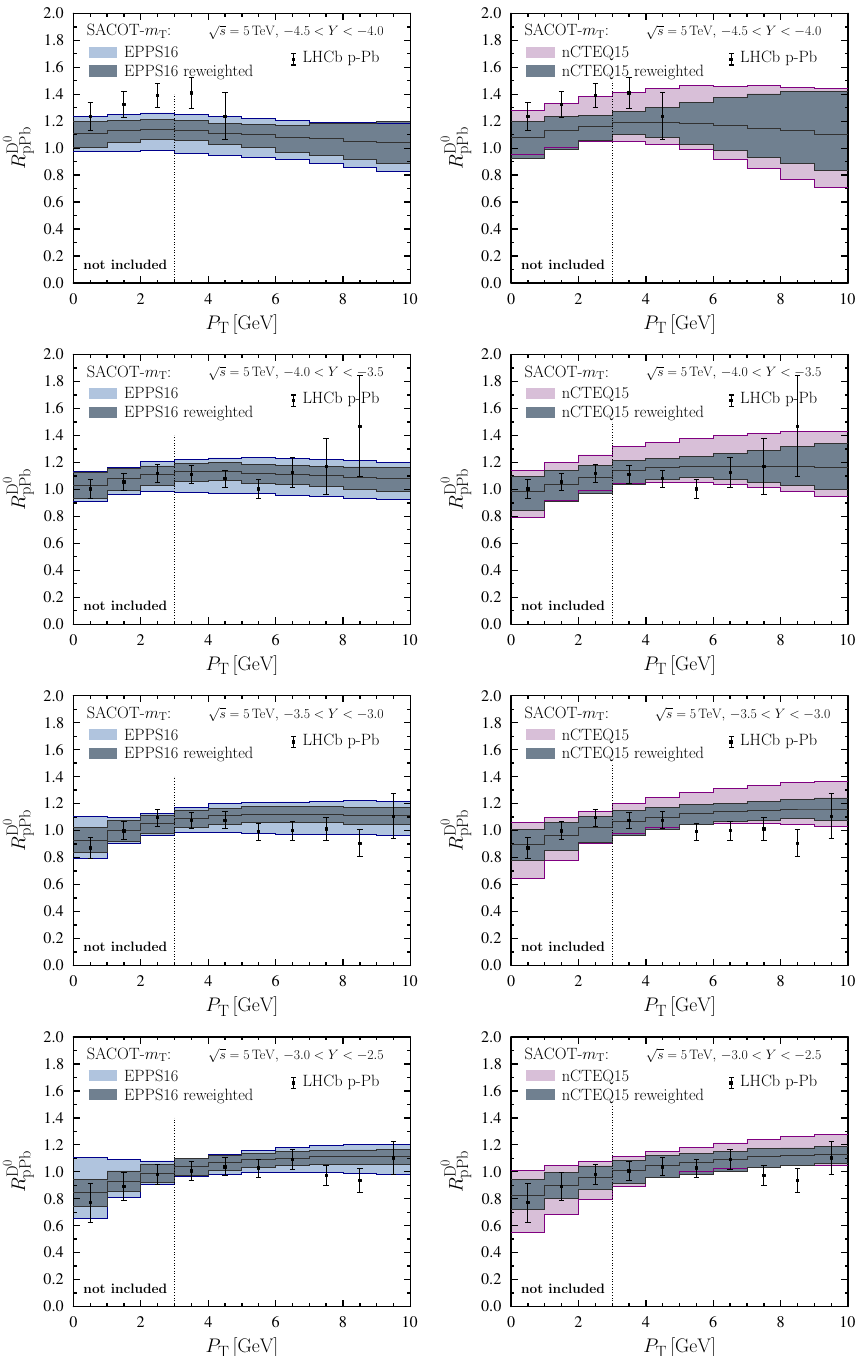
Figure 6 . Nuclear modi(cid:12)cation ratio for D 0 production at backward rapidities in p+Pb collisions at p s NN = 5 : 0 TeV from the LHCb measurement [42] (black points with error bars) compared with the SACOT- m T calculation using the EPPS16 (left) and nCTEQ15 (right) nPDFs with uncertainties before (light-coloured bands) and after reweighting (dark-grey bands) including the central result from the reweighted nPDFs